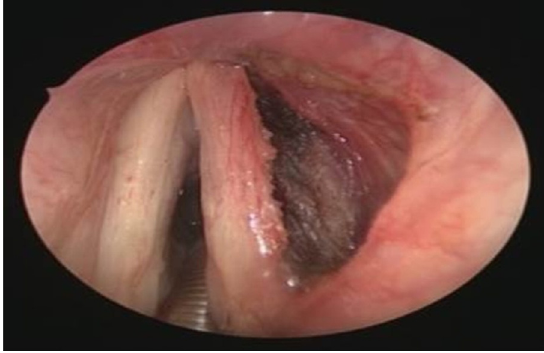
Figure 3 Endoscopic view after the removal.